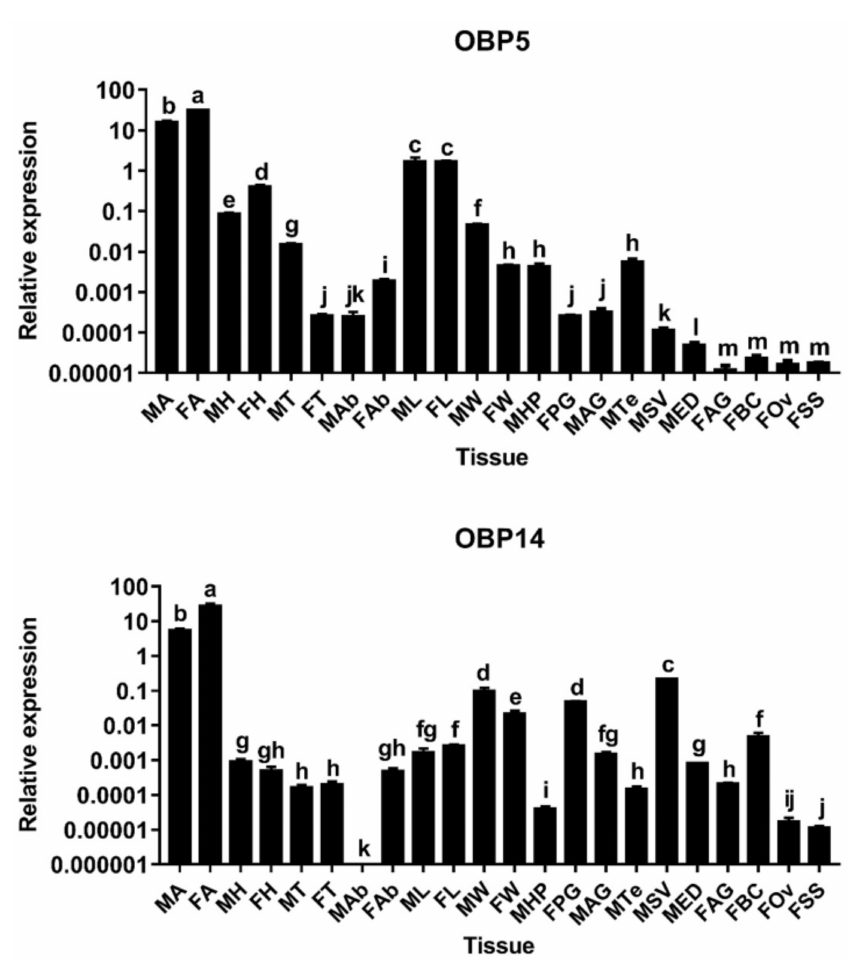
Figure 2. Relative expression of two candidate DabiOBP genes in various tissues of D. abietella . DabiRPL8 was used as a control gene to normalize the expression of target genes. MA, male antennae; FA, female antennae; MH, male heads without antennae; FH, female heads without antennae; MT, male thoraxes; FT, female thoraxes; MAb, male abdomens; FAb, female abdomens; ML, male legs; FL, female legs; MW, male wings; FW, female wings; MHP, male hairpencils; FPG, female pheromone glands; MAG, male accessory glands; MTe, male testes; MSV, male seminal vesicles; MED, male ejaculatory ducts; FAG, female accessory glands; FBC, female bursa coplatrix; FOv,